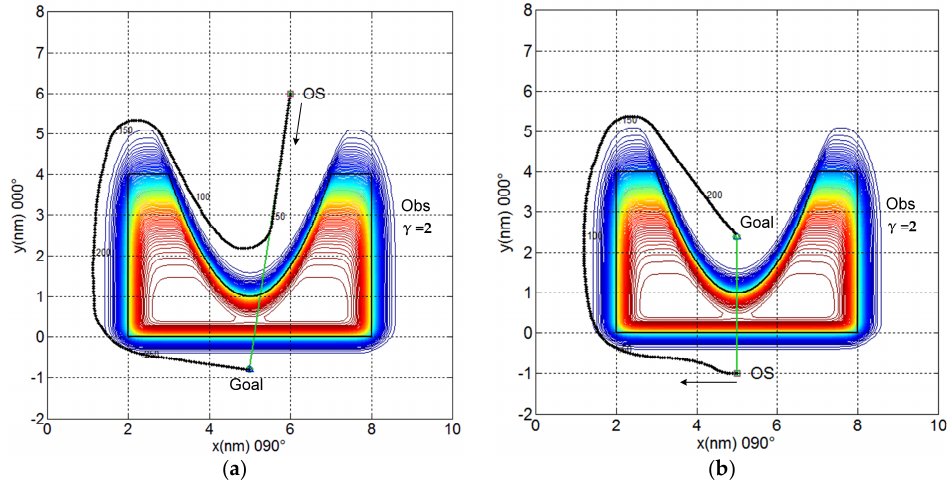
Figure 11. The static obstacle is a U-shaped slot, a composite potential field composed of a parabola and a rectangle, where the parabola c is expressed as 3 x 2 − 30 x + 79 − 4 y . The boundary of this obstacle is indicated by the black lines. ( a ) The own ship is not trapped in the U-shaped slot and can successfully reach the goal, which is very close to the obstacle. ( b ) The goal is located inside the U-shaped slot and is very close to the obstacle; the own ship can still reach the goal.